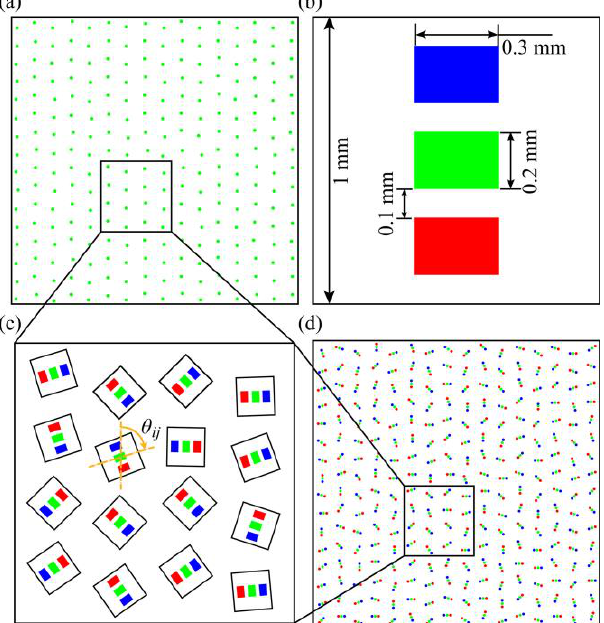
Figure 1. Schematics of multi-hyperuniform sampling arrangement: ( a ) Hyperuniform point pattern generated by the randomization procedure for green luminous point; ( b ) The geometry of a single LED chip; ( c ) Randomized rotations were introduced to each LED chip; ( d ) Multi-hyperuniform point pattern of the LED array.